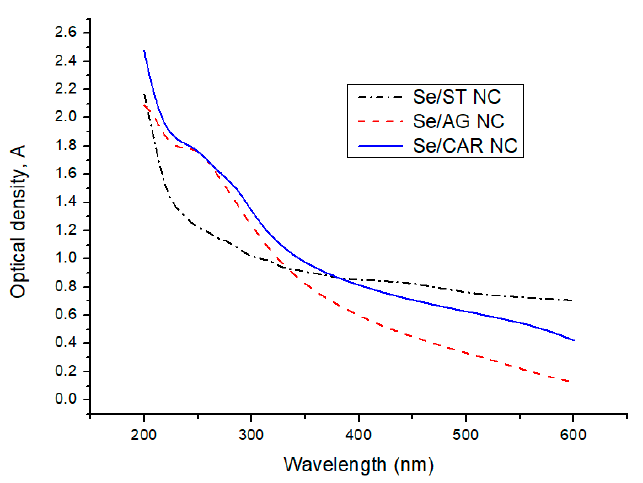
Figure 2. UV-Vis optical density spectra of SeNPs. Diffractograms represent XPA spectra and are graphs of the dependence of the scat- tered radiation intensity on the scattering angle. The diffractograms of Se/AG and Se/CAR NCs were typical with no pronounced reflexes and demonstrated only wide halos from polysaccharide matrices (Figure 3).